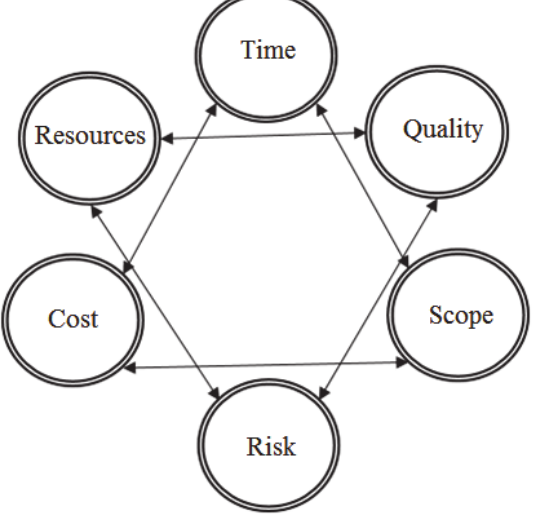
Fig. 1. Project constraints